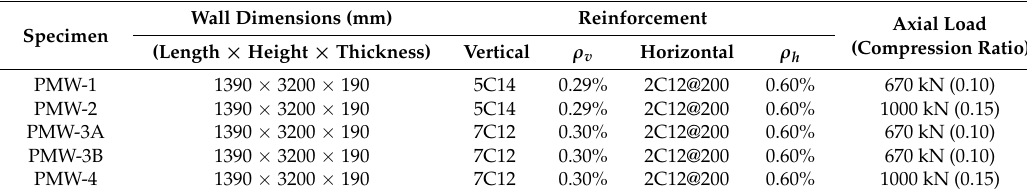
Figure 2. Design of test specimens (mm).